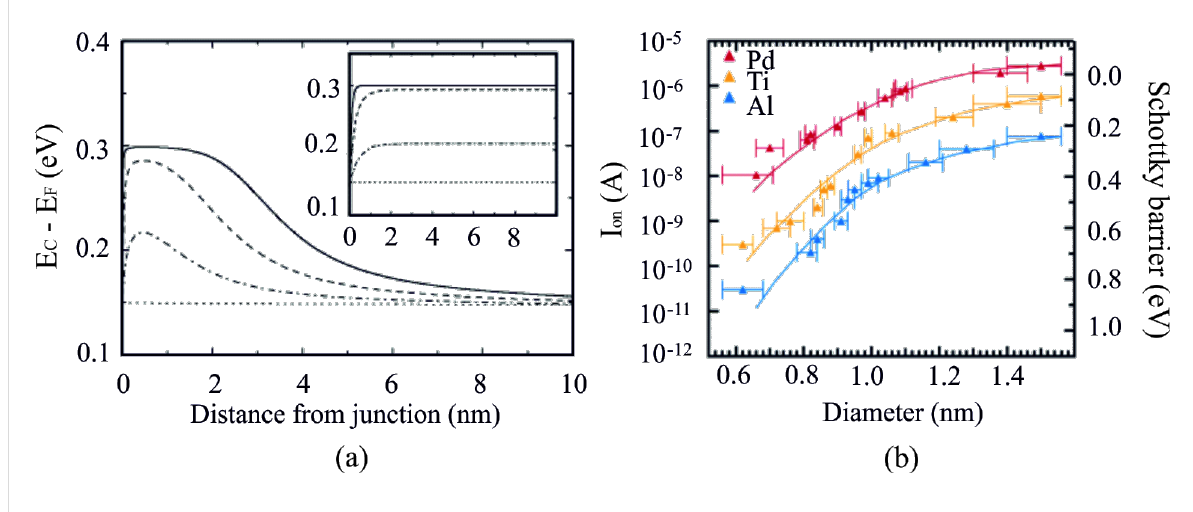
Figure 2: The role of the Fermi level pinning effect at the metal–semiconductor interface. a) Simulation of band bending at the metal–SWCNT (semi- conducting SWCNT, diameter: 1.4 nm) interface for a low work function metal. The dotted, dash-dotted, dashed, and solid lines correspond to the different pinning strength 0, 0.01, 0.1, and 1 state/(atom eV), respectively. The pinning effect for the planar junction is shown in the inset for compari- son using the same simulation parameters. b) The experimental results of the on current as a function of CNT diameter with different metals. The clear dependence of the Schottky barrier height on the type of metal and the SWCNT diameter is observed. This indicates that no Fermi level pinning effect exists at the metal–SWCNT interface. Figure reprinted with permission from (a) [14] copyright 2000 American Physical Society, (b) [15] copy- right 2005 American Chemical